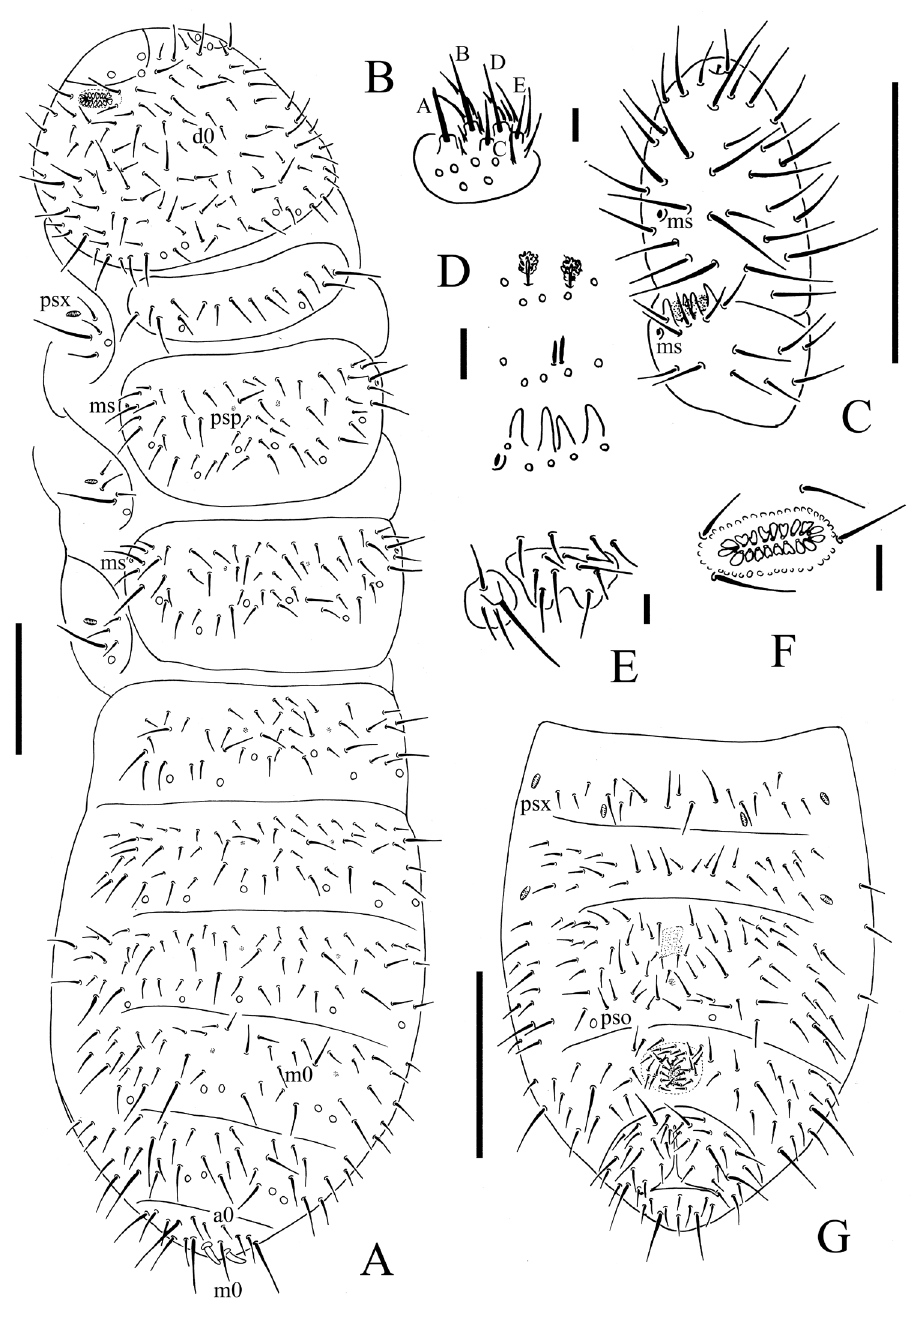
Figure 1. Uralaphorura liangshuiensis sp. n. A dorsal side of body B labium C Ant. III–IV D clubs, rods and papillae of AIIIO E labrum and maxillary palp F PAO G ventral side of Abd. II–VI. Scale bars: 0.1 mm A, C, G ; 0.01 mm B, D–F